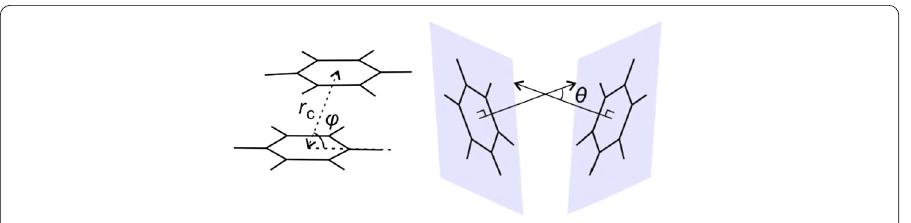
Figure 11 Parameters of benzene ring positional relationship ( r c : distance between benzene ring centers, θ : angle formed by normal vectors of two benzene planes, ϕ : angle between the benzene plane and the central line)